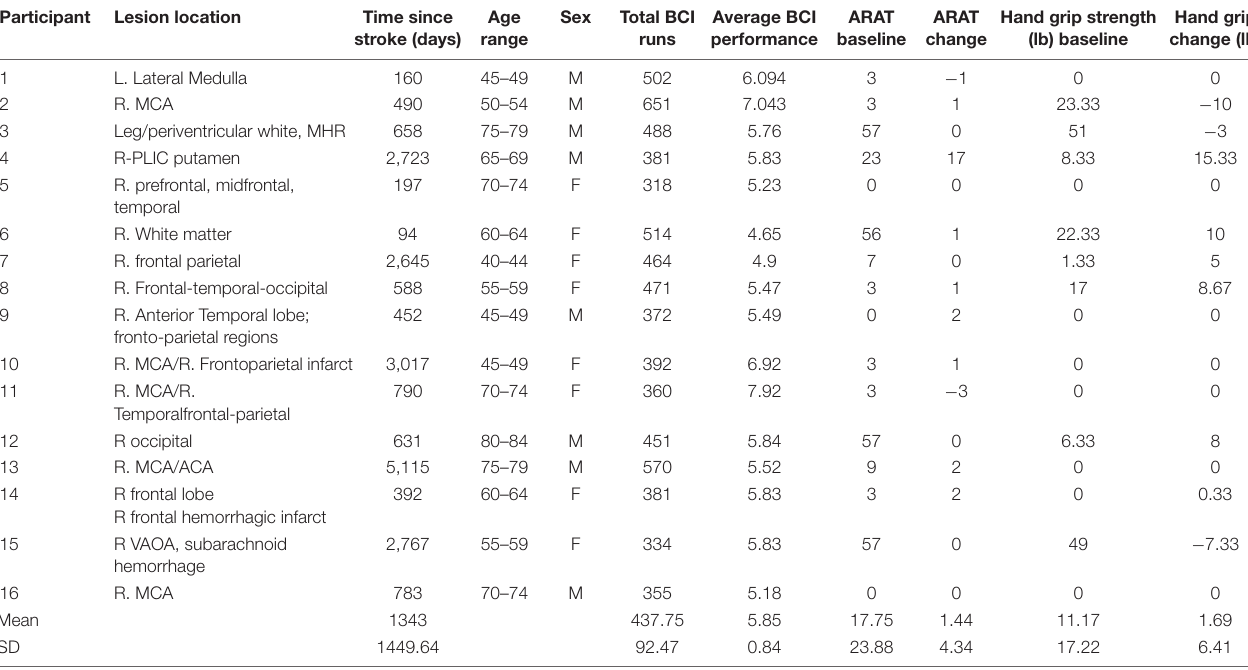
TABLE 1 | Demographics of n = 16 stroke